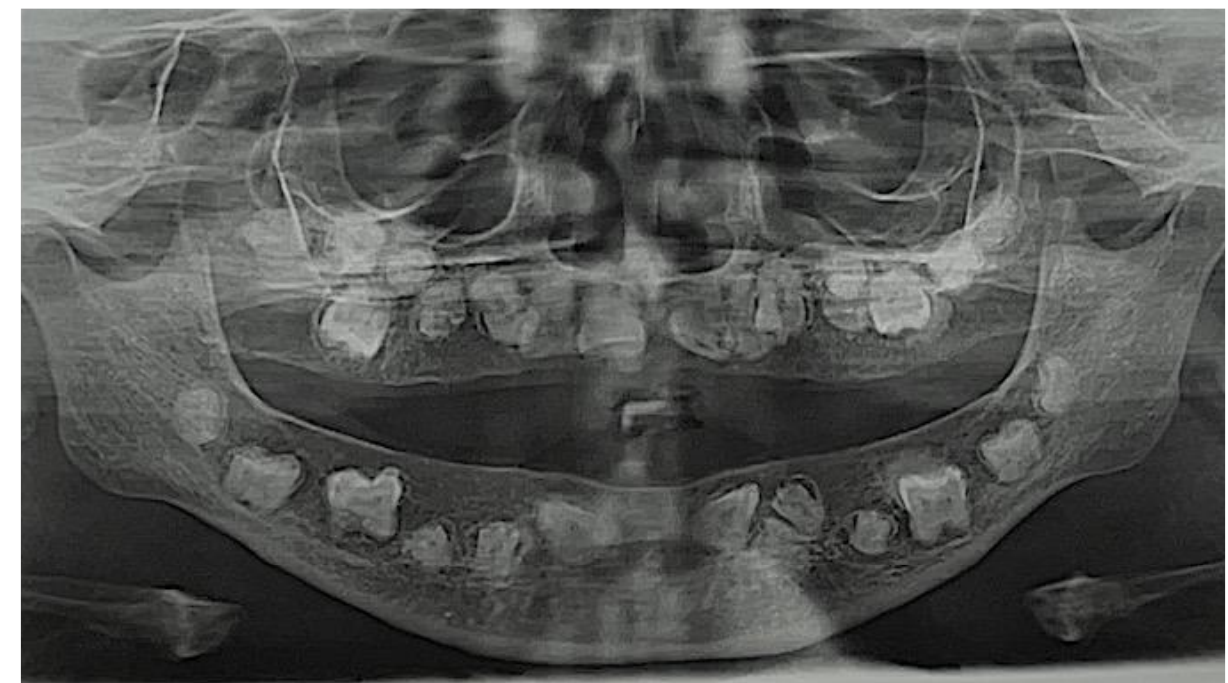
Figure 3. Dental panoramic radiography.